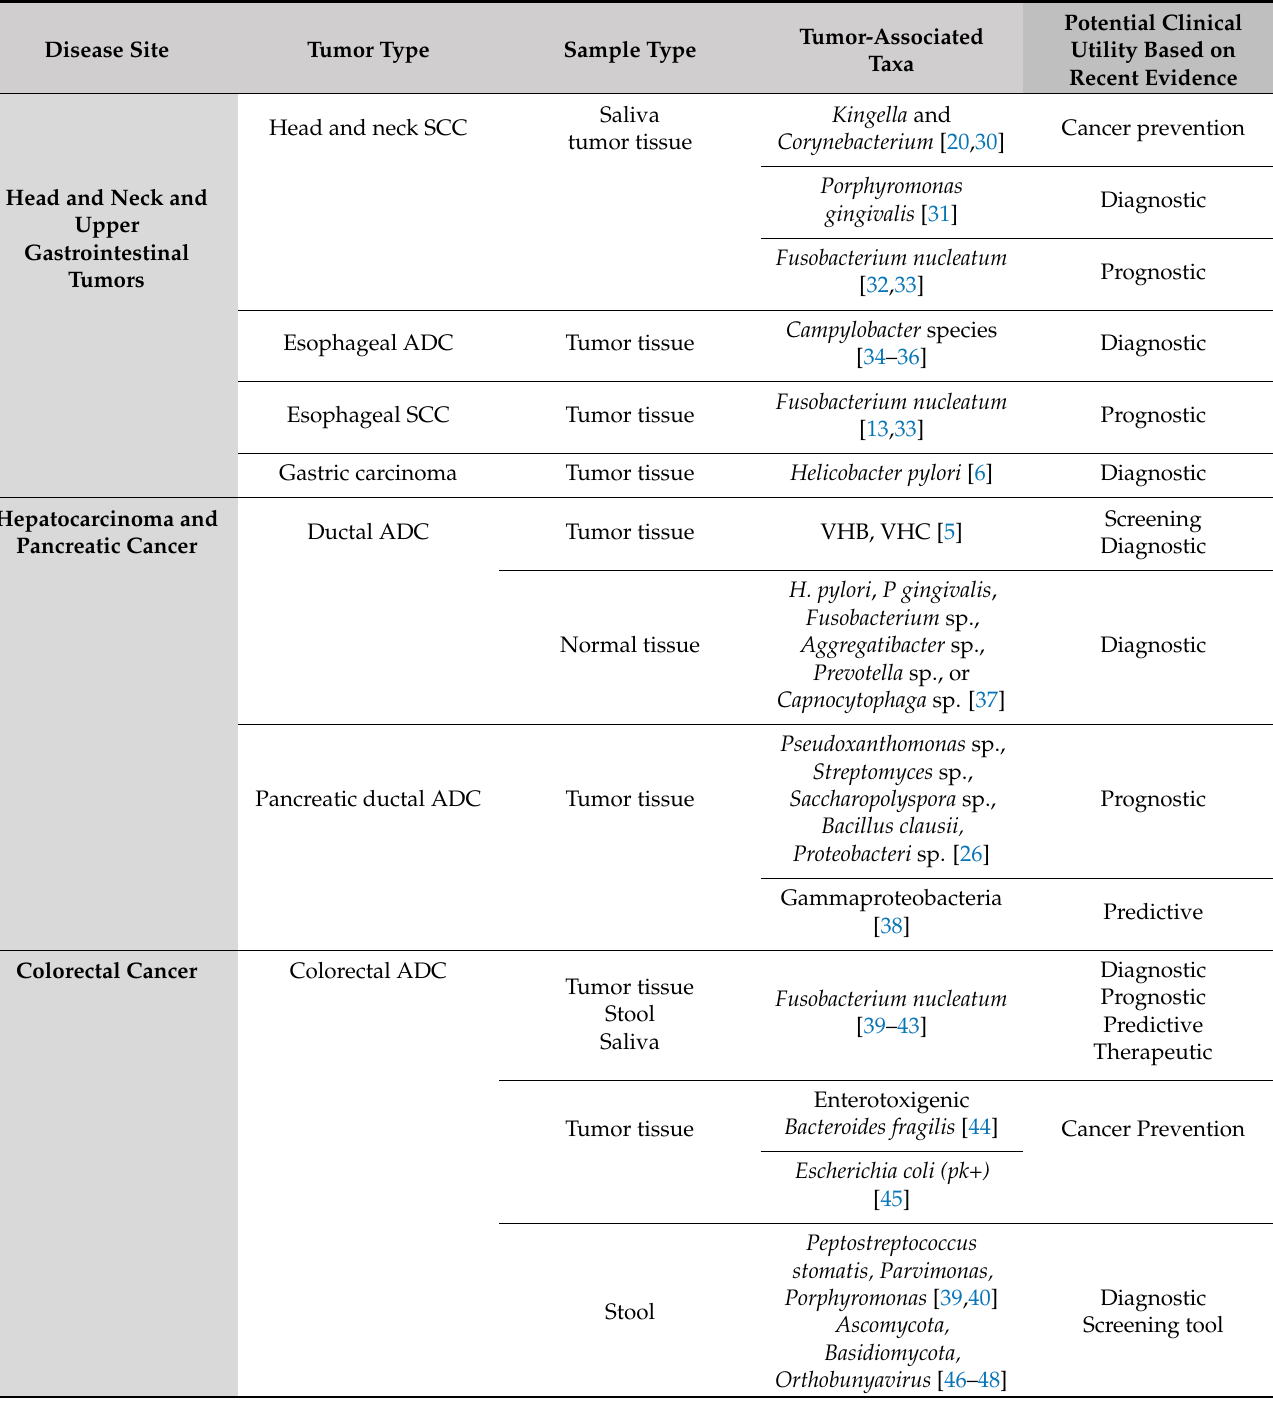
Table 1. Tumor-associated